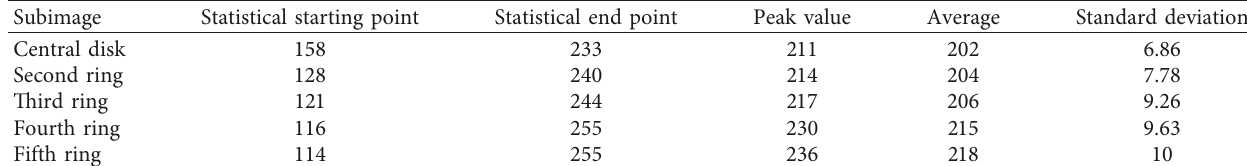
Table 1: Statistical table of gray level.